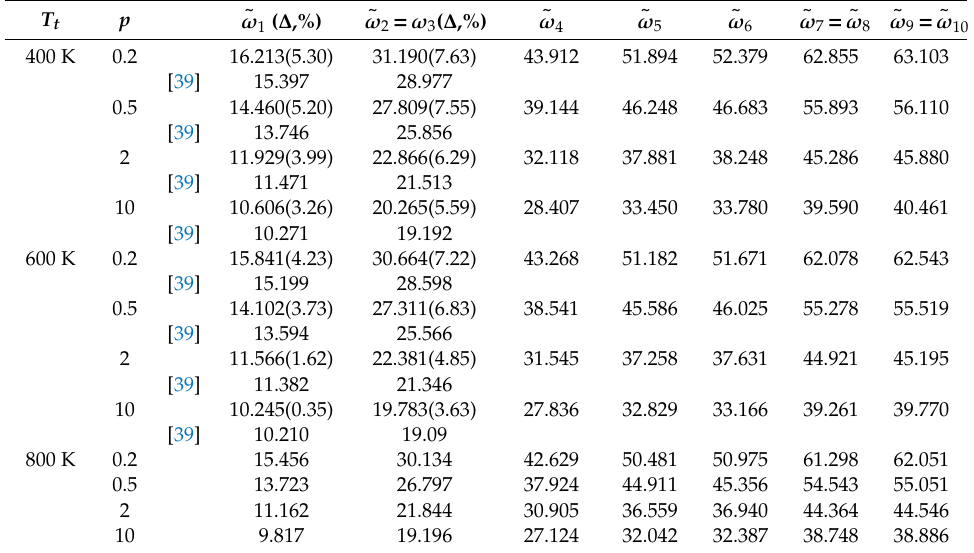
Table 8. The first ten nondimensional frequencies of CCCC SUS304 / Si 3 Ni 4 functionally graded square 1-8-1 sandwich plates thermally loaded by the nonlinear temperature